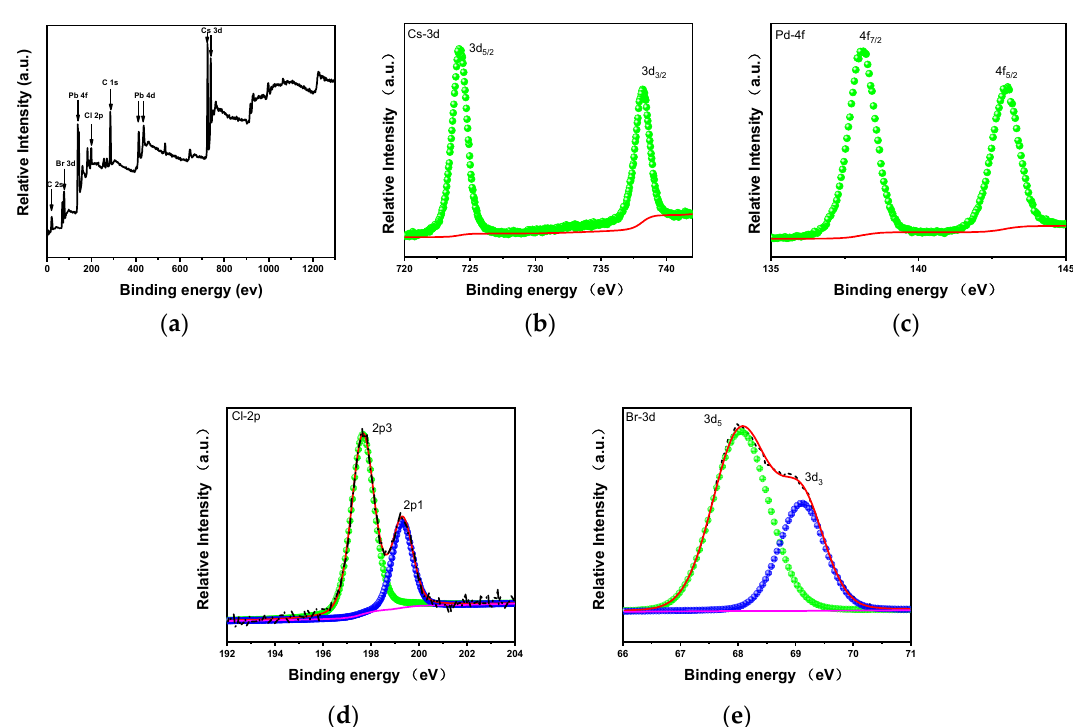
Figure 3. ( a ) The XPS spectrum of CsPbCl 1 Br 2 nanocrystals; ( b ) XPS spectra of Cs 3d in CsPbCl 1 Br 2 nanocrystals; ( c ) XPS spectra of Pb 4f in CsPbCl 1 Br 2 nanocrystals; ( d ) XPS spectra of Cl 2p in CsPbCl 1 Br 2 nanocrystals; ( e ) XPS spectra of Br 3d in CsPbCl 1 Br 2 nanocrystals.